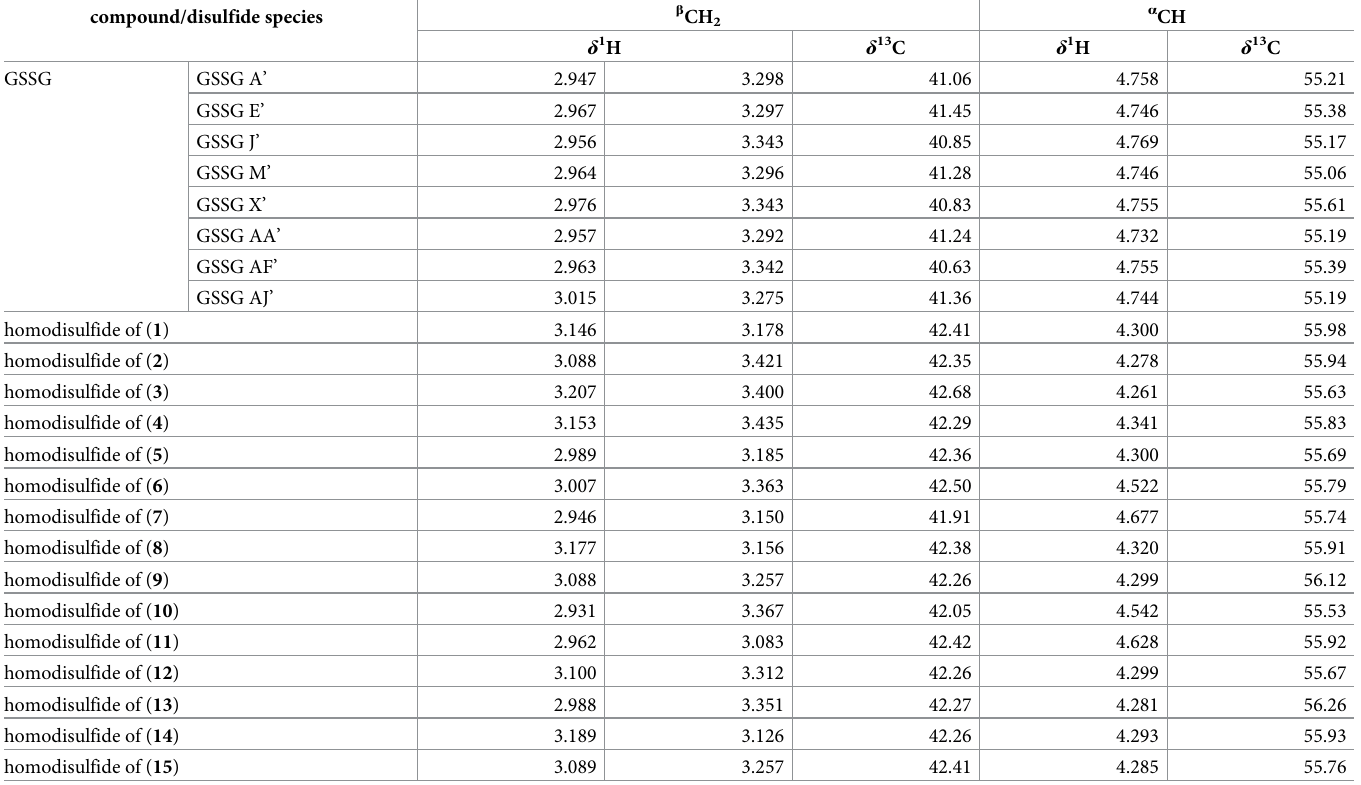
Table 5. The species-specific chemical shifts determined for the additional compounds studied (beyond cysteine and cystine) bearing disulfide moiety. The uncer- tainty of determination for chemical shift on the ppm scale is 0.001 and 0.01 for 1 H and 13 C chemical shift values, respectively. The microspecies symbols for glutathione disulfide are not all depicted on Fig 3; labeling here is assumed to continue on the GSSG microspeciation scheme in alphabetical order, with labeling continuing after Z with AA, AB, and so on. compound/disulfide